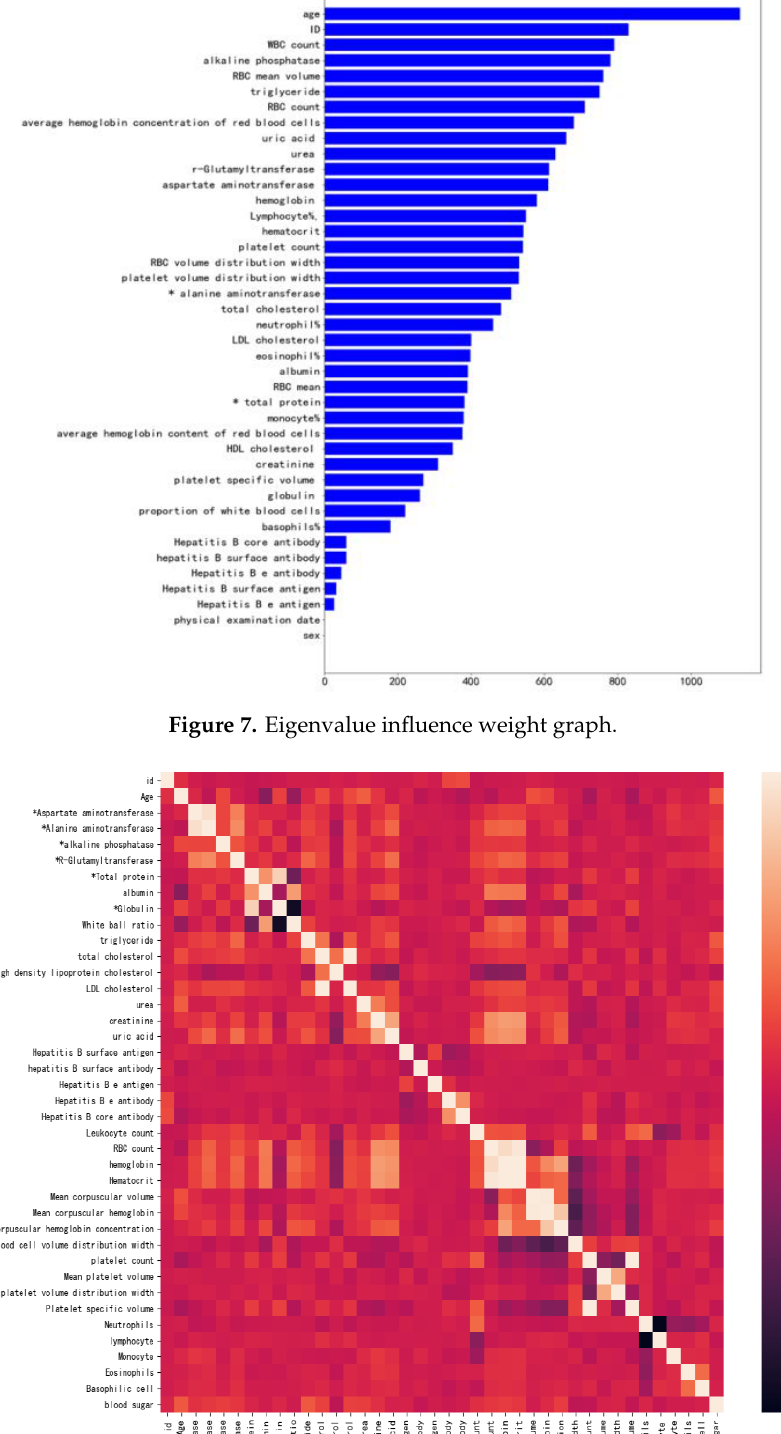
Figure 8. Matrix thermodynamic diagram of the eigenvalue correlation coefficient.